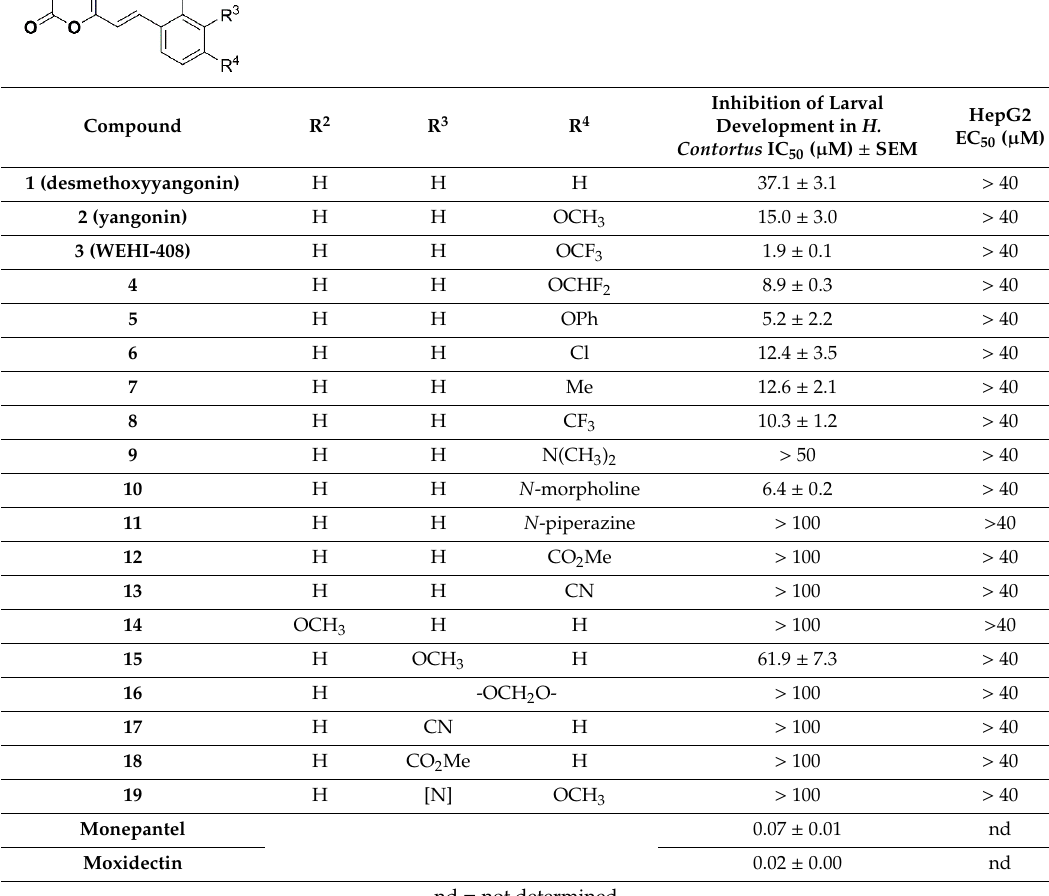
Molecules 2020 , 25 , x FOR PEER REVIEW 3 of 8 Table 1. The activities of synthesized kavalactone analogues against Haemonchus contortus in the larval development assay and HepG2 human hepatoma cells in vitro. A comparison of half maximum inhibitory concentration (IC 50 ) values of the synthesized compounds with those of monepantel and moxidectin, expressed as mean IC 50 ± standard error of the mean (SEM).